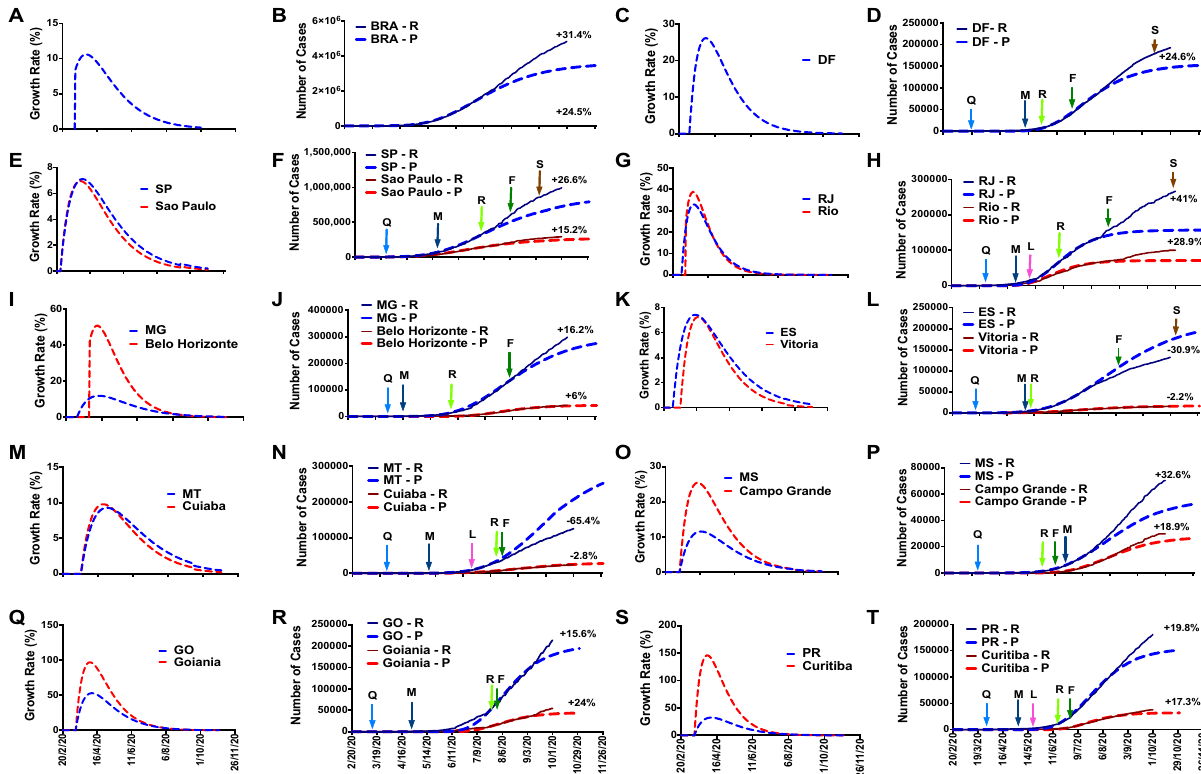
Figure 1. ( A ), ( C ), ( E ), ( G ), ( I ), ( K ), ( M ), ( O ), ( Q ), ( S ): Cumulative COVID-19 cases; and ( B ), ( D ), ( F ), ( H ), ( J ), ( L ), ( N ), ( P ), ( R ), ( T ): Growth rate of COVID-19 in Brazil, Distrito Federal (DF), Sao Paulo (SP), Rio de Janeiro (RJ), Minas Gerais (MG), Espirito Santo (ES), Mato Grosso (MG), Mato Grosso do Sul (MS), Goias, and Parana (PR), respectively, with their respective capitals. − R: reported number; − P: predicted number;